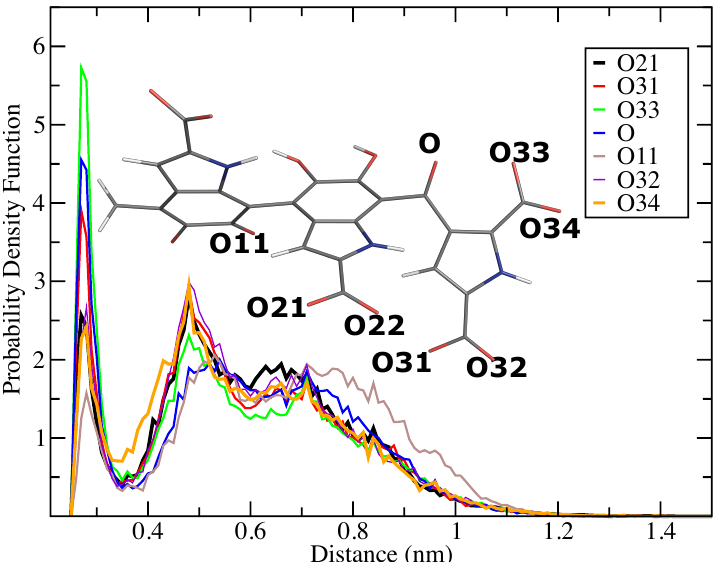
Figure 6. Distribution of K + - charged DHICA’s oxygen distances for the system of four charged DHICA-eumelanins. O21, O31, and O33 stand for the oxygen atoms of the hydroxyl group in carboxylic anions, and O22, O32, and O34 are the oxygen atoms of the carboxyl group in the carboxylic ions group. O is the oxygen atom of the ketone in PTCA, and O11 was chosen as reference. Snapshots from a mixture of 25 uncharged and 25 charged DHICA eumelanins after about 1900 ns are shown in Figure 7. As the figure shows, the uncharged eumelanins (green) become shielded by the charged ones (pink). As Figure 7a shows, a number of the charged molecules and counterions remain dispersed in the solution. Figure 7b shows a zoomed-in view displaying aggregated uncharged eumelanins and charged eumelanins that are within 3 Å of uncharged eumelanins as well as the K + ions that are within 3 Å of charged eumelanins. The K + ions that bind with carboxylic acids are shown as dots in order to identify them better. During the aggregation process, one of the charged eumelanins became trapped inside the cluster. The figure shows that due to hydrophobic sites in the uncharged molecules, they prefer to interact with themselves rather than with water molecules. The charged eumelanins, however, tend to form hydrogen bonds with water molecules or bind with the K + ions. In addition to the above, a few of the charged eumelanins are in contact with uncharged eumelanins via π − π